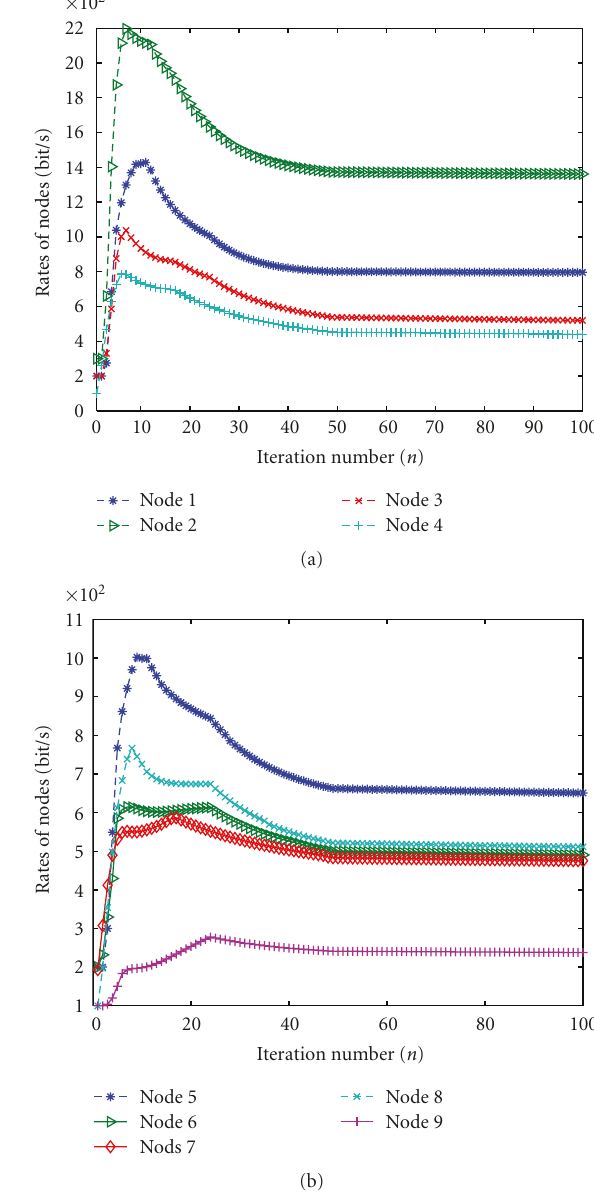
Figure 3: Convergence of the ASMOP algorithm by using con- straint method.